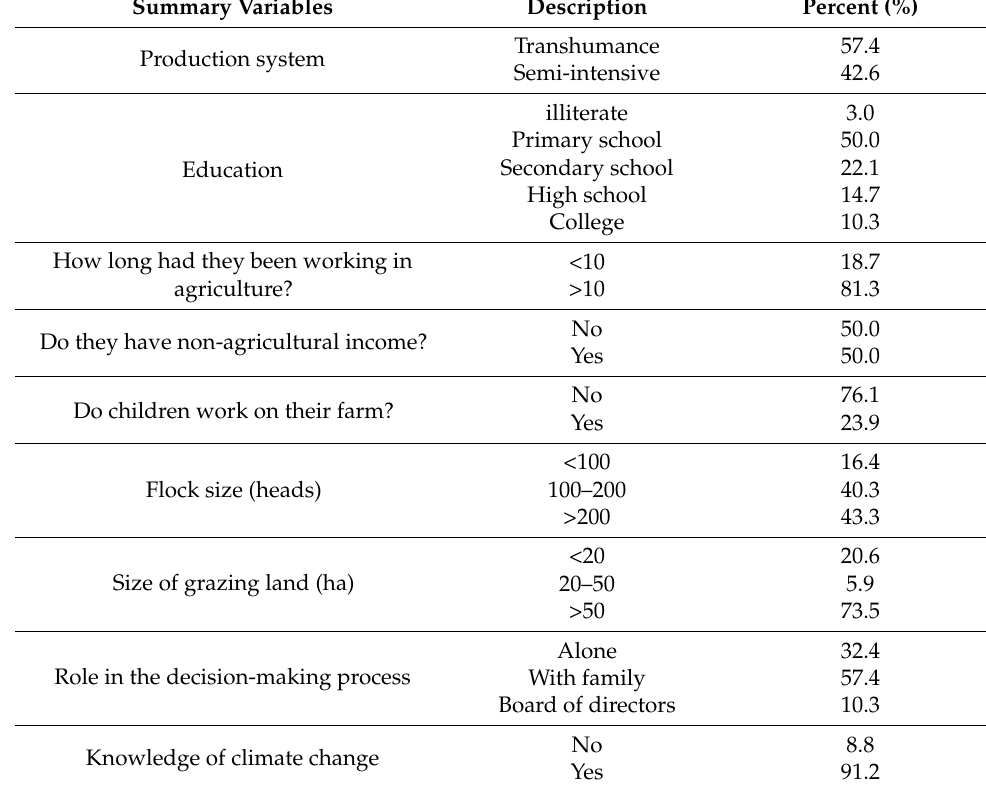
Table 1. Socio-economics of the farmers’